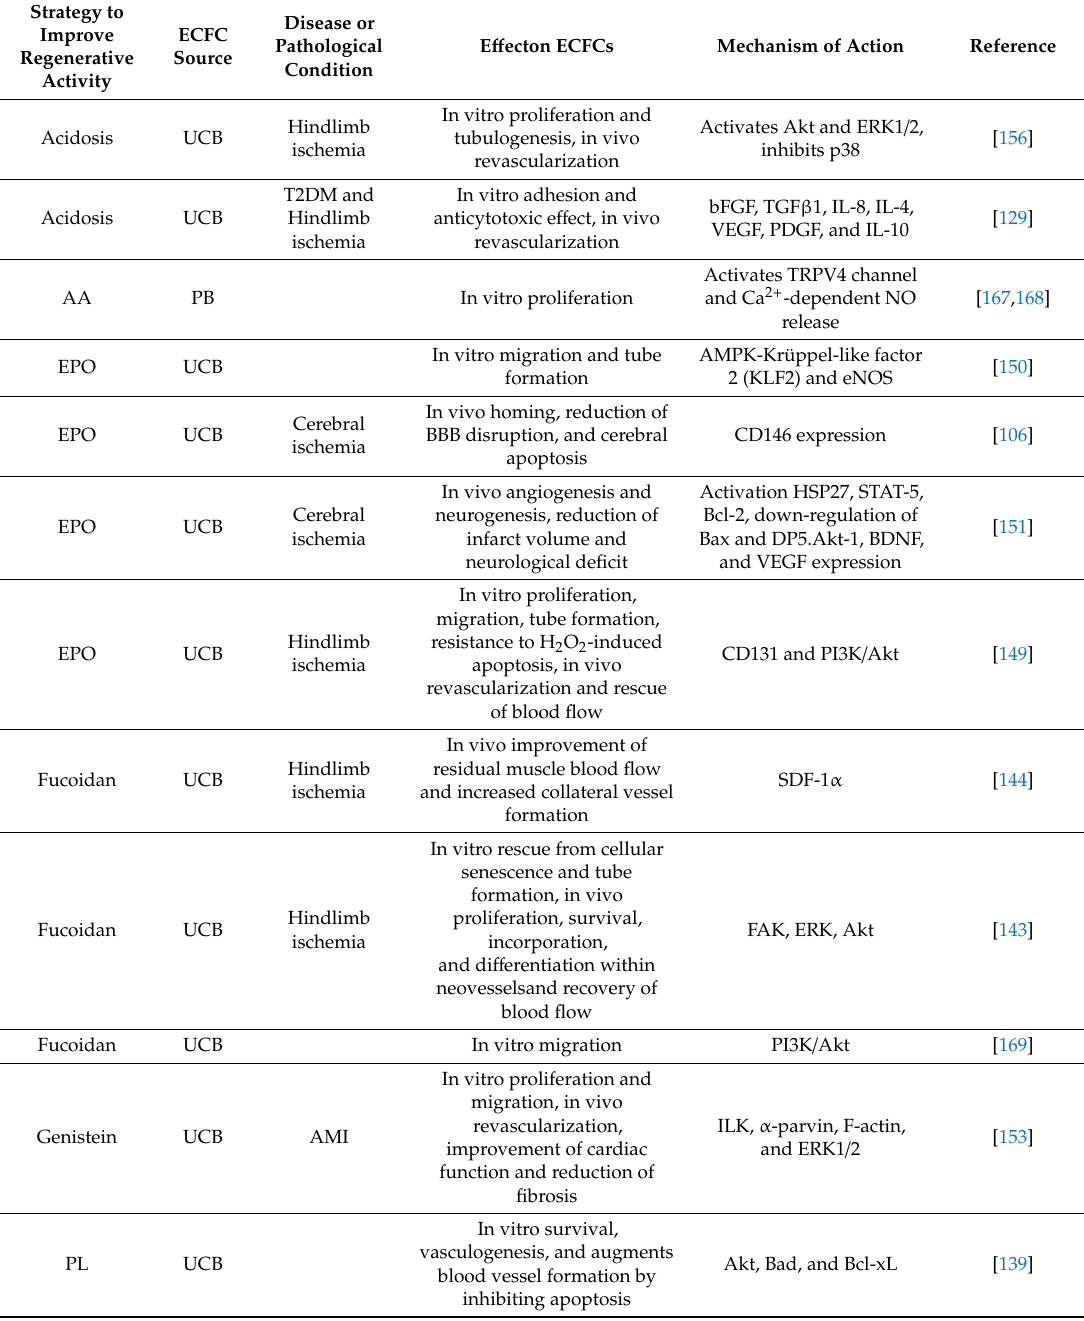
Table 2. Strategies to boost ECFCs expansion ex